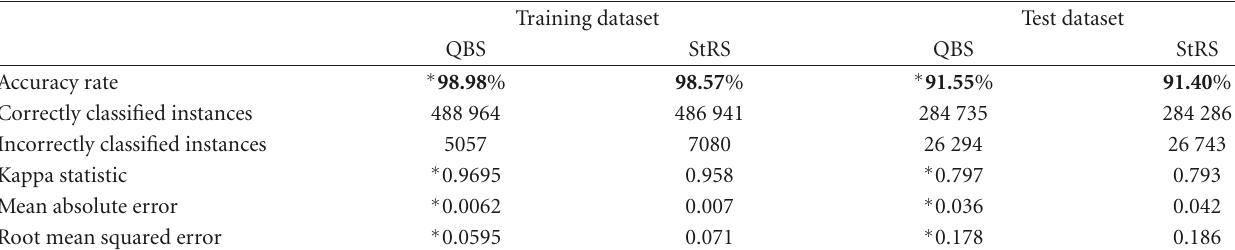
Table 1: Summary of results.